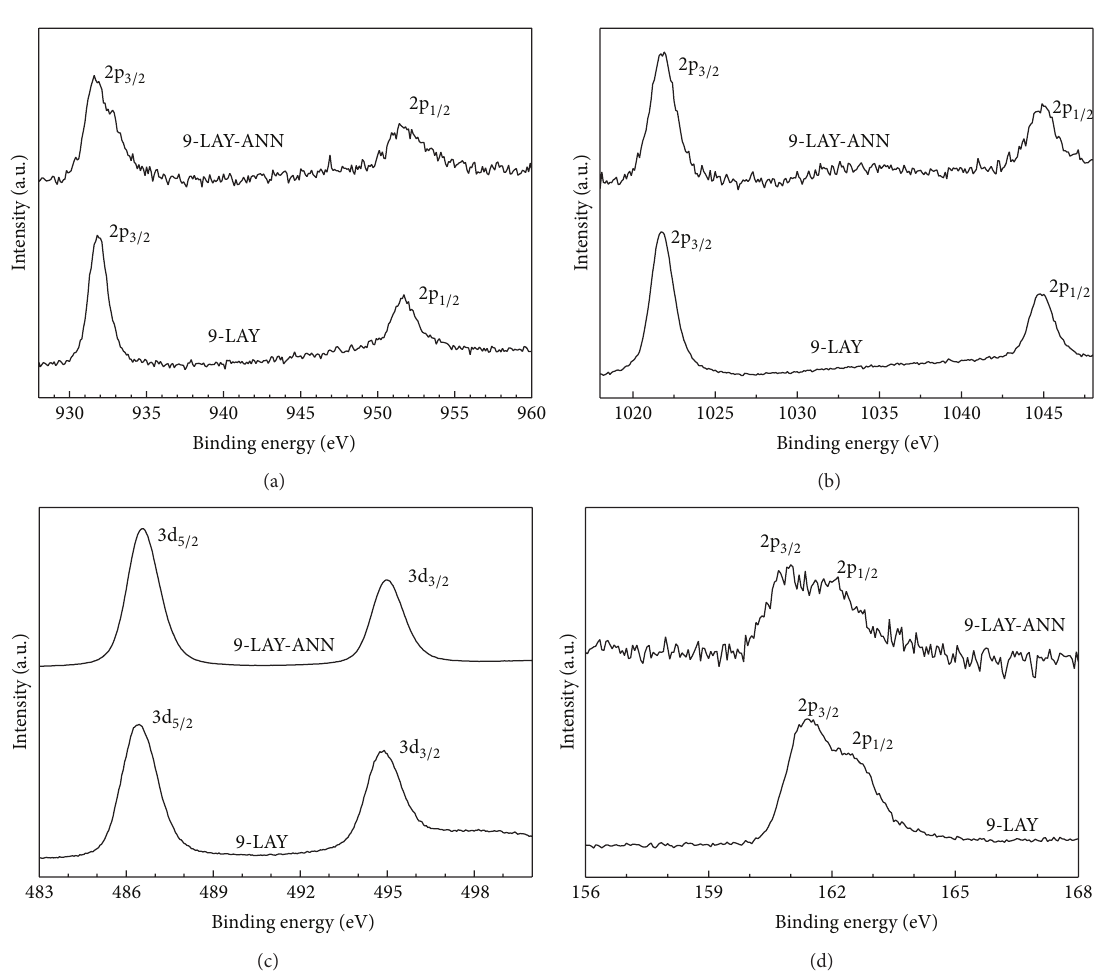
Figure 2: XPS spectra of 9-LAY and 9-LAY-ANN CZTS thin films: (a) Cu 2p, (b) Zn 2p, (c) Sn 3d, and (d) S 2p.